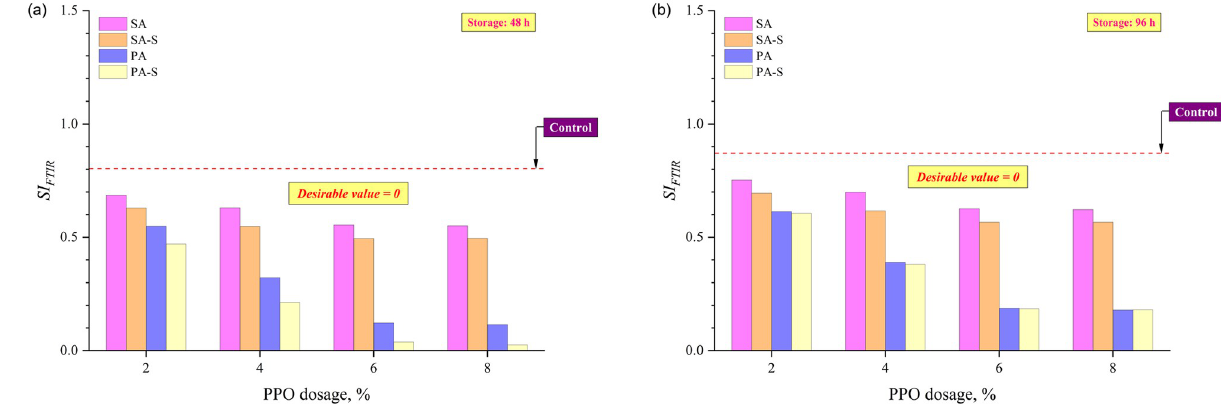
Fig 10. Chemical separation index ( SI FTIR ) after (a) 48 h and (b) 96 h of thermal storage.